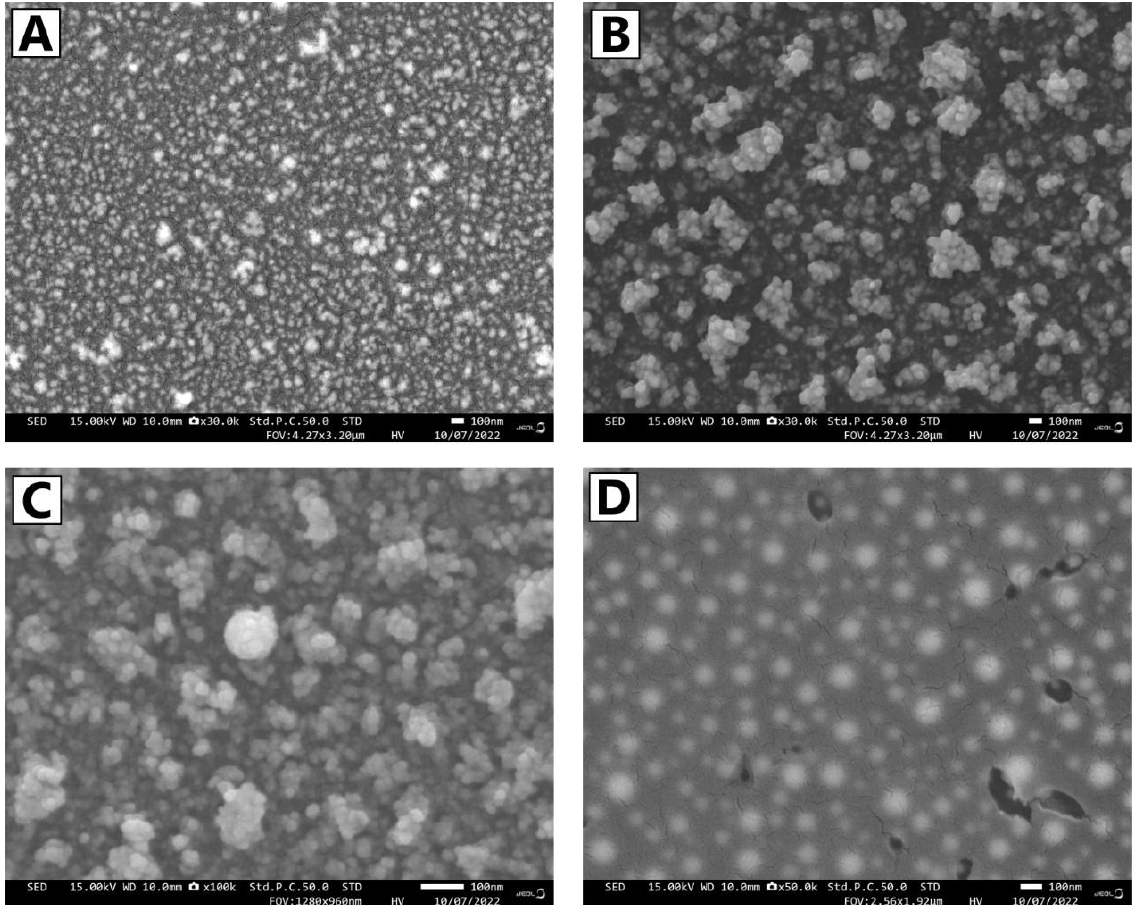
Figure 3. SEM image of sparked gold wire on the surface of quartz: ( A ), gold wires sparked in ambient air; ( B ), gold sparked in the magnetic field in the air; ( C ), gold wire sparked in nitrogen flow; ( D ), gold sparked in nitrogen flow under the magnetic field. Additional images available in supplementary information. Table 1. Size distribution of particles calculated from SEM image using ImageJ software.